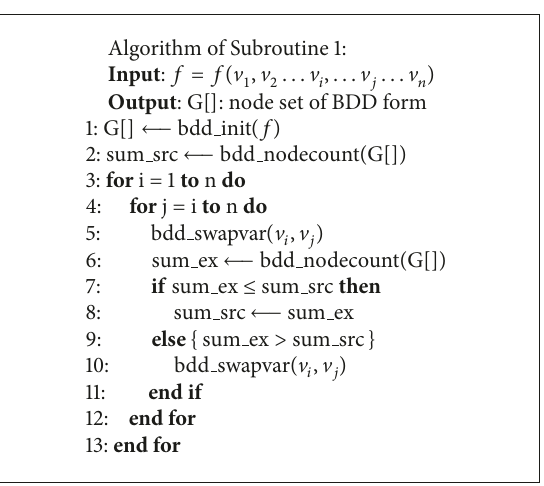
Algorithm 1: The algorithm of subroutine 1 in the BDD-based extraction algorithm.